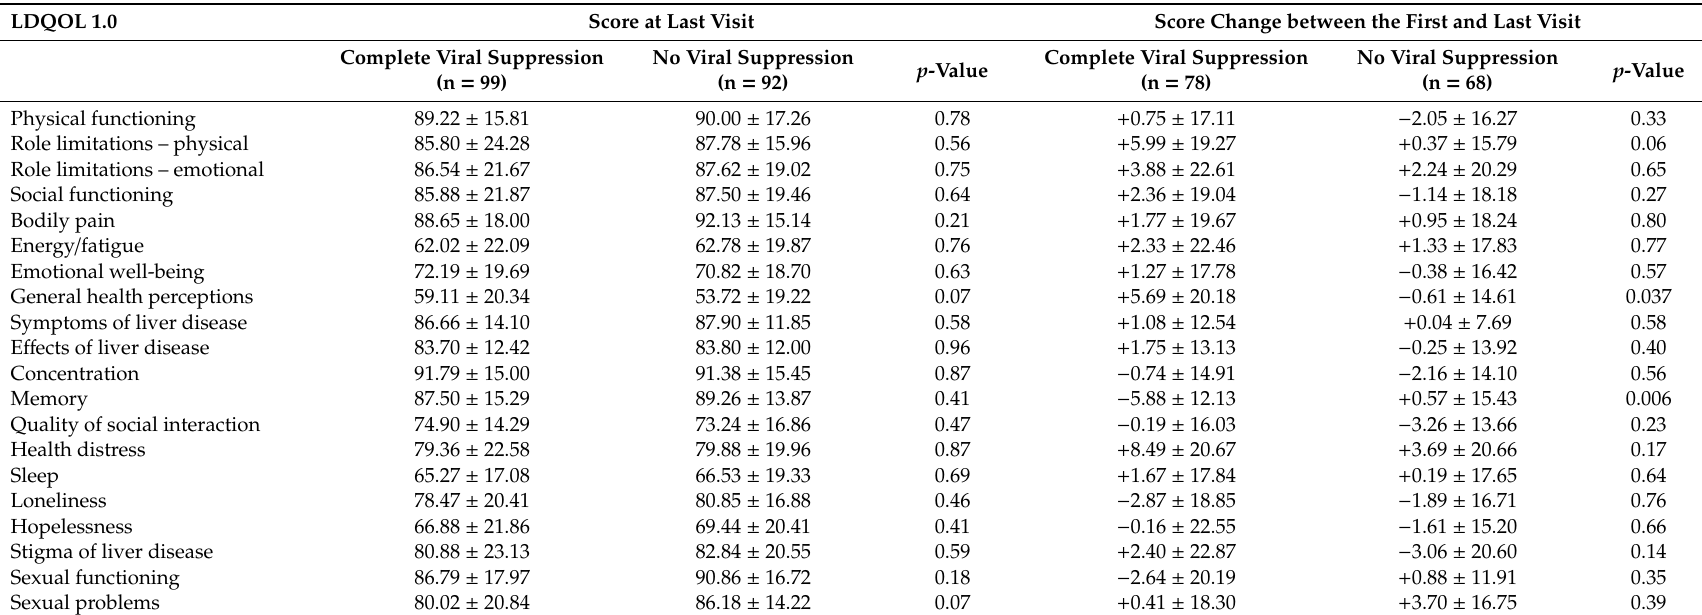
Table 6. Comparison of descriptive statistics according to the viral suppression status at the last